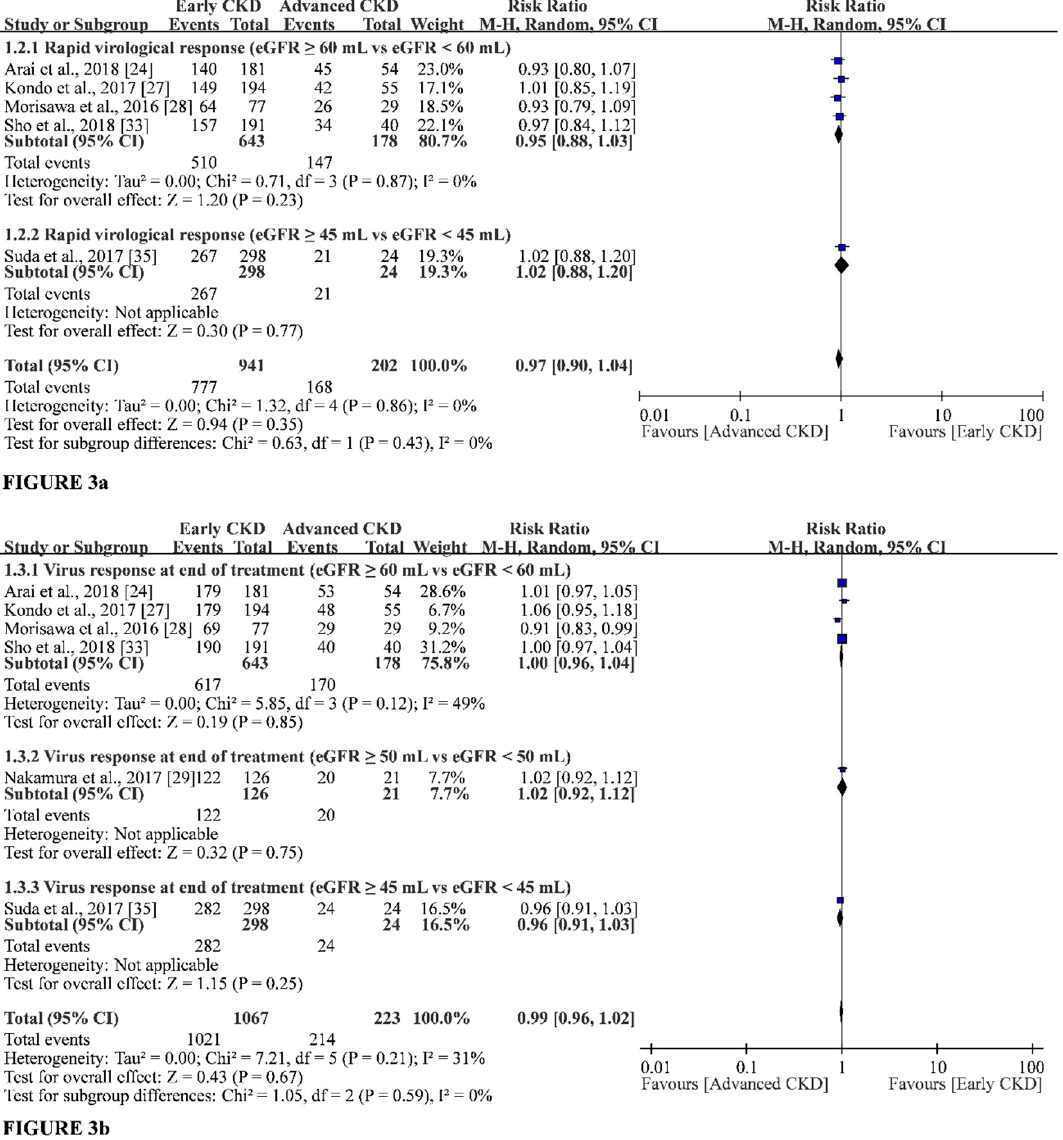
Figure 3. Forest plot of rapid virologic response and virologic response at the end of treatment. eGFR, estimated Glomerular filtration rate.